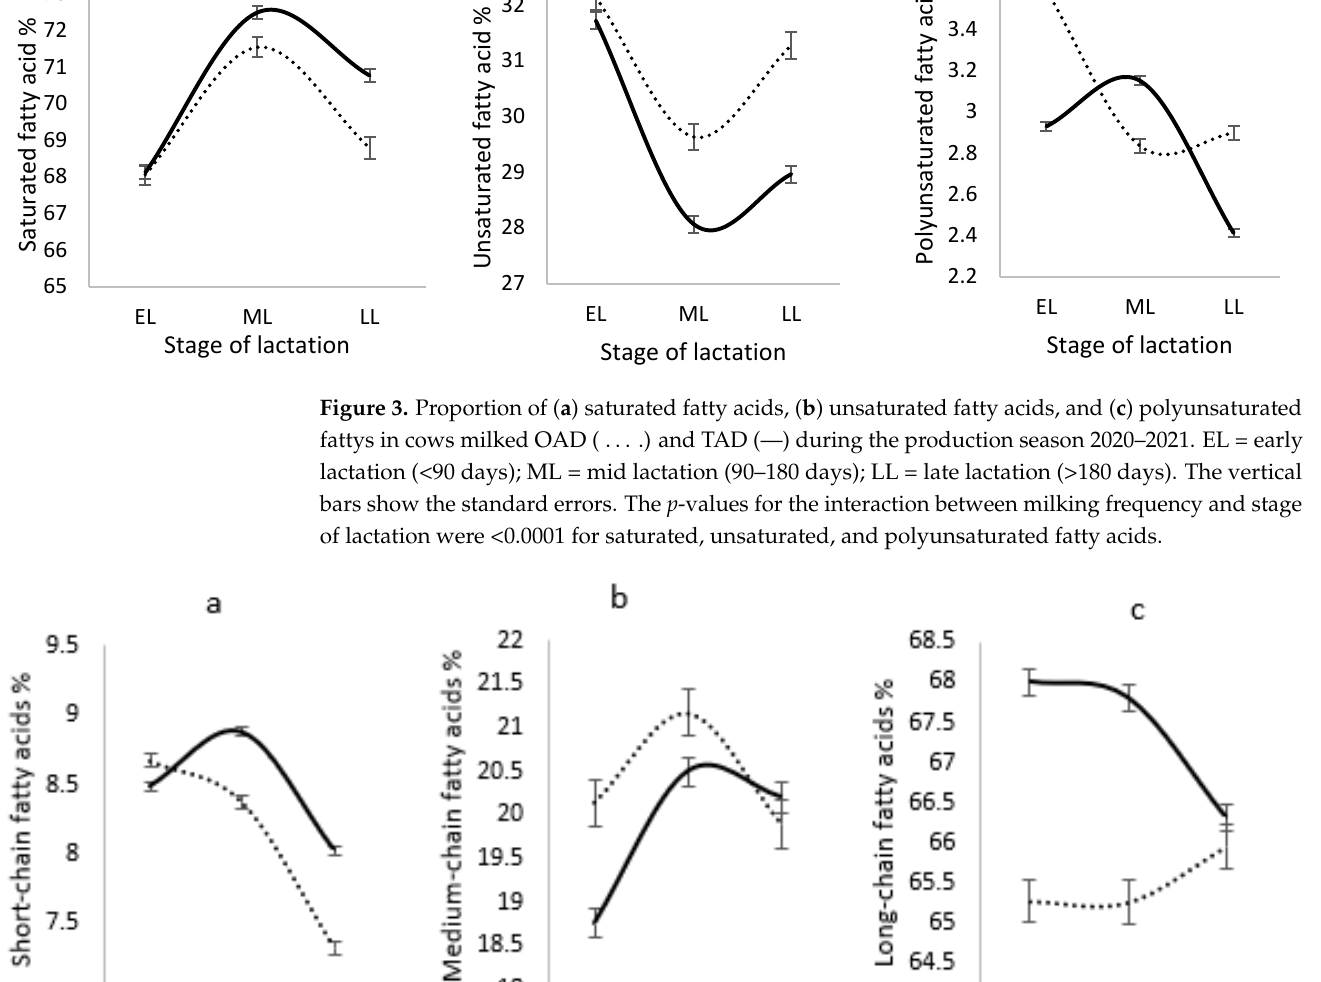
Figure 4. Proportion of ( a ) short-chain fatty acids, ( b ) medium-chain fatty acids, ( c ) and long-chain fatty acids in cows milked OAD ( . . . .) and TAD (—) during the production season 2020–2021. EL = early lactation (<90 days); ML = mid lactation (90–180 days); LL = late lactation (>180 days). The vertical bars show the standard errors. The p -values for the interaction between milking frequency